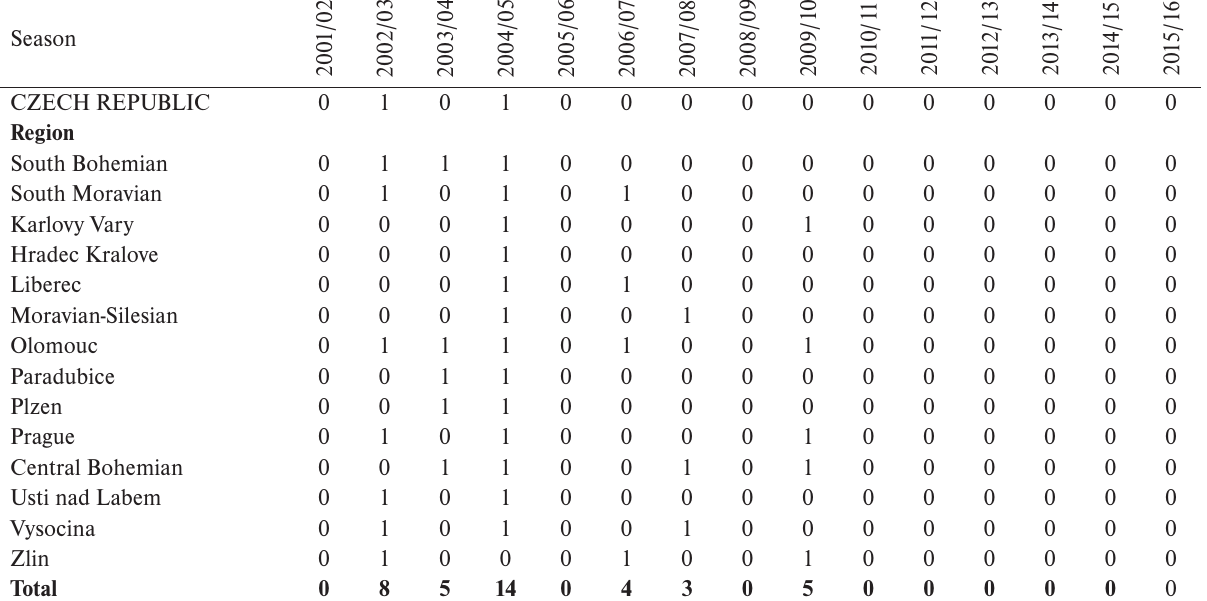
Table 1. The presence (denoted by 1) or absence (denoted by 0) of outliers in 15 seasons (2001/02-2015/16) in the Czech Republic and its 14 regions. The total numbers of outliers per season are indicated in the last row of the